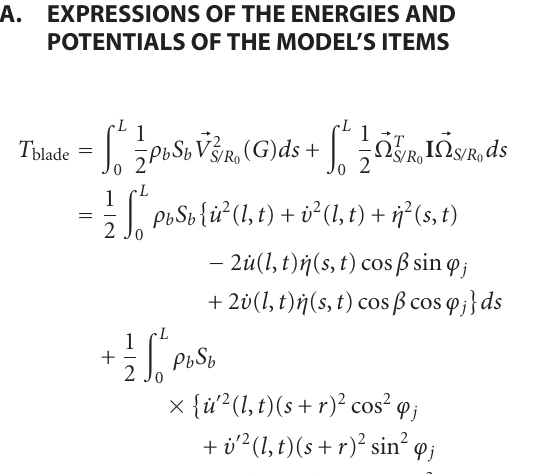
Figure 16: Unstable frequencies of a two-flexible-bladed rotor as a function of its stagger angle and its rotational speed.